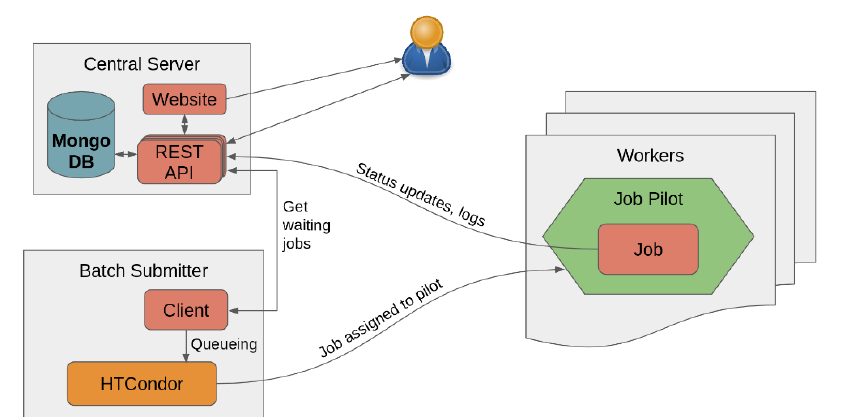
Fig. 2. A diagram of communications between different parts of IceProd, after the 2.4 release. The Fig. 1. A diagram of communications between different parts of IceProd, before the 2.4 release. Client has reduced functionality, with the central REST API handling most